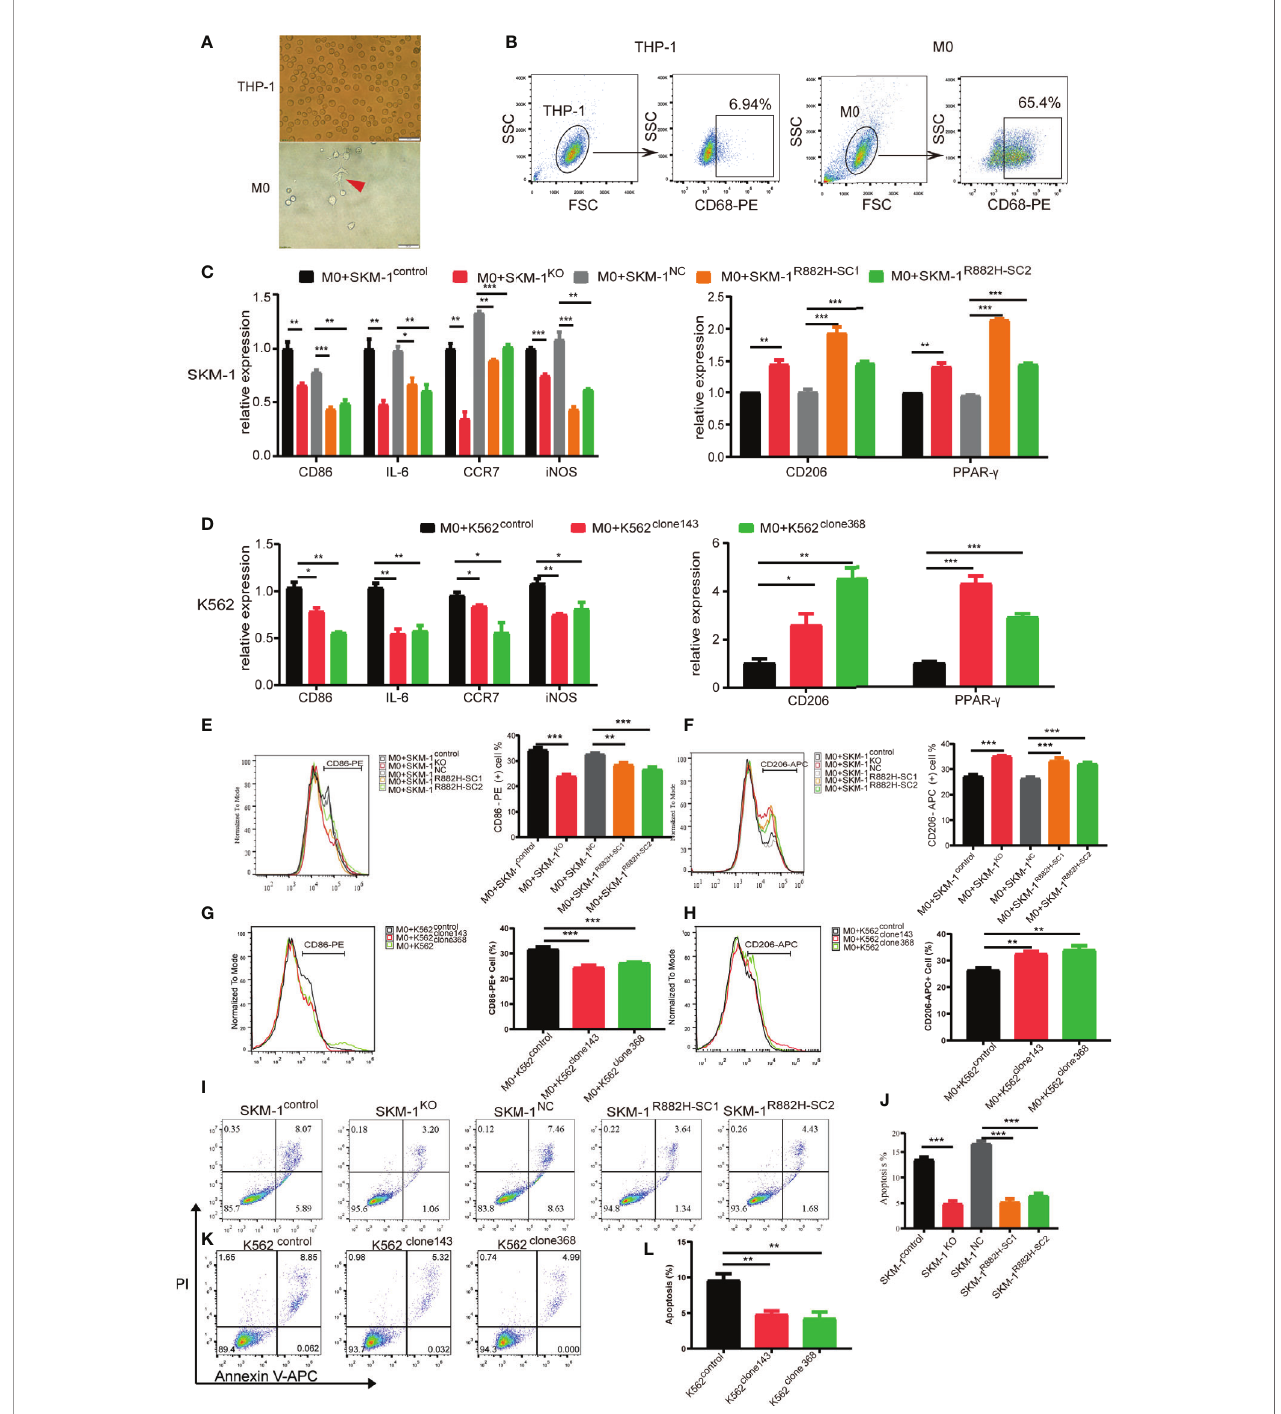
FIGURE 3 | DNMT3A-mutated AML cells attenuated M1 macrophage polarization and resist its killing effect in vitro . (A) The morphological changes of THP-1 differentiation into M0 macrophages, the red arrow points to M0 macrophages. (B) The expression of CD68 in THP-1 after stimulation with PMA. (C, D) The mRNA expression of CD86 , IL - 6 , iNOS , CCR7 (M1 marker) and CD206 , PPAR - g (M2 marker) was measured by qRT-PCR in macrophages after co-cultured with SKM-1 cells and K562 cells respectively. (E – H) The expression of CD86 and CD206 in macrophages after co-cultured with AML cells was analyzed using fl ow cytometry. The histogram is a statistical graph of the fl ow chart. (I – L) Representative dot plots and column diagram showing the apoptosis rate of AML cells after co-cultured with M1 macrophages. All the results are presented as mean ± standard deviation of three independent experiments (n = 3). *p < 0.05, **p < 0.01, and ***p < 0.0001 represent signi fi cant differences compared with the